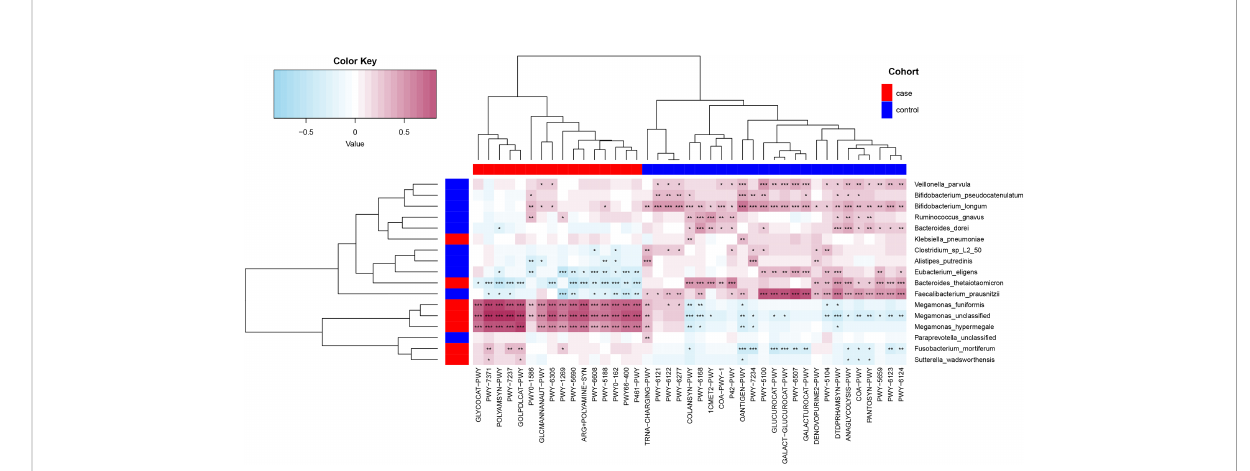
FIGURE 6 Spearman ’ s correlation matrix for functional shifts and microbiome characteristics in the case and control groups. Blue cell color represented a negative correlation; red cell color represented a positive correlation. * P < 0.05, ** P < 0.01, and *** P < 0.001.